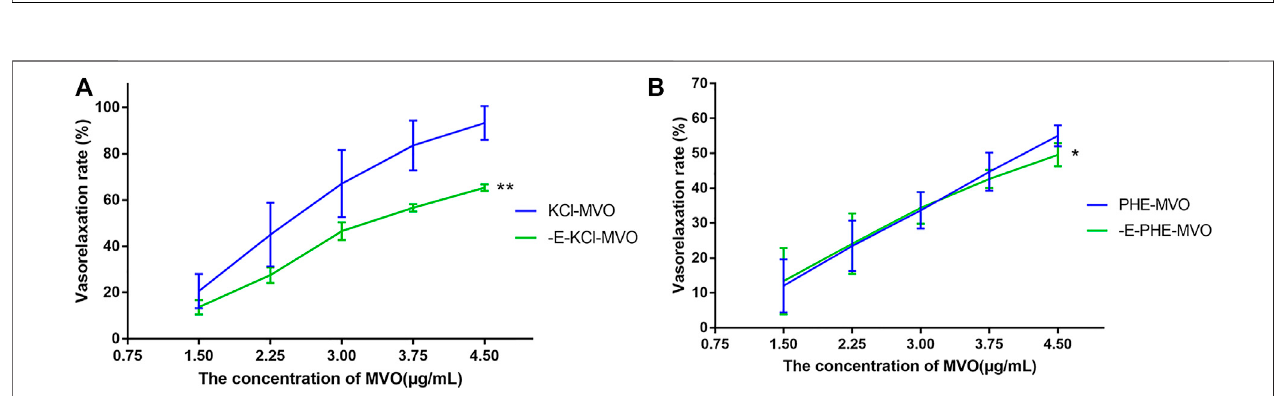
FIGURE5| RelaxanteffectsofMVOon+Eor-Eaorticringsprecontractedwith (A) KCl(60 mM)or (B) PHE(10 μ M).Thealternationoftensionwasexpressedasa percentage of the active contraction induced by KCl (60 mM) or PHE (10 μ M). n = 6. Means ± S.D. * p < 0.05, ** p < 0.01 vs. KCl/PHE-MVO group.